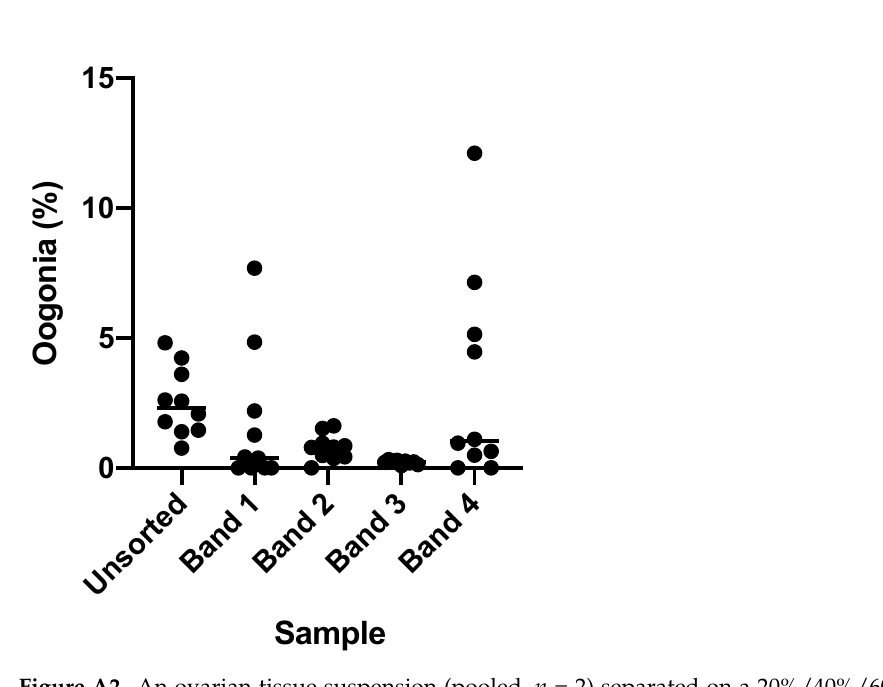
Figure A1. The number of cells recovered per gram of tissue was calculated for each treatment, ( A ) fresh tissue, tissue cryopreserved with DMSO and Ethylene Glycol (EG), and tissue cryopreserved in cryomedium with no permeating cryoprotectant (NEG), as well as ( B ) different concentrations of DMSO from 1.0M to 2.0M. No significant difference was reported in cells/g between treatment groups in graph “A” ( p = 0.0905), and “B” ( p = 0.0798; One-way ANOVA with Tukey’s post hoc test).